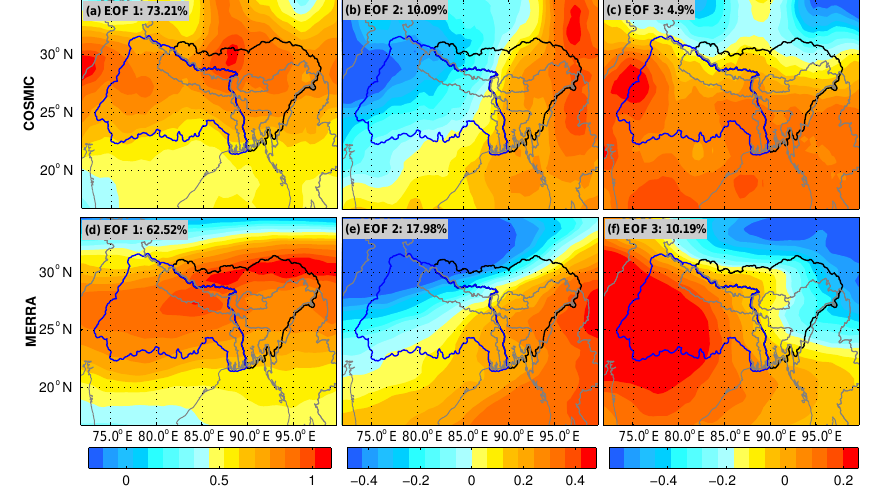
Figure 11. The first three leading EOFs of tropopause temperature ( ◦ C) based on MERRA data and COSMIC RO data for the period August 2006 to December 2013.